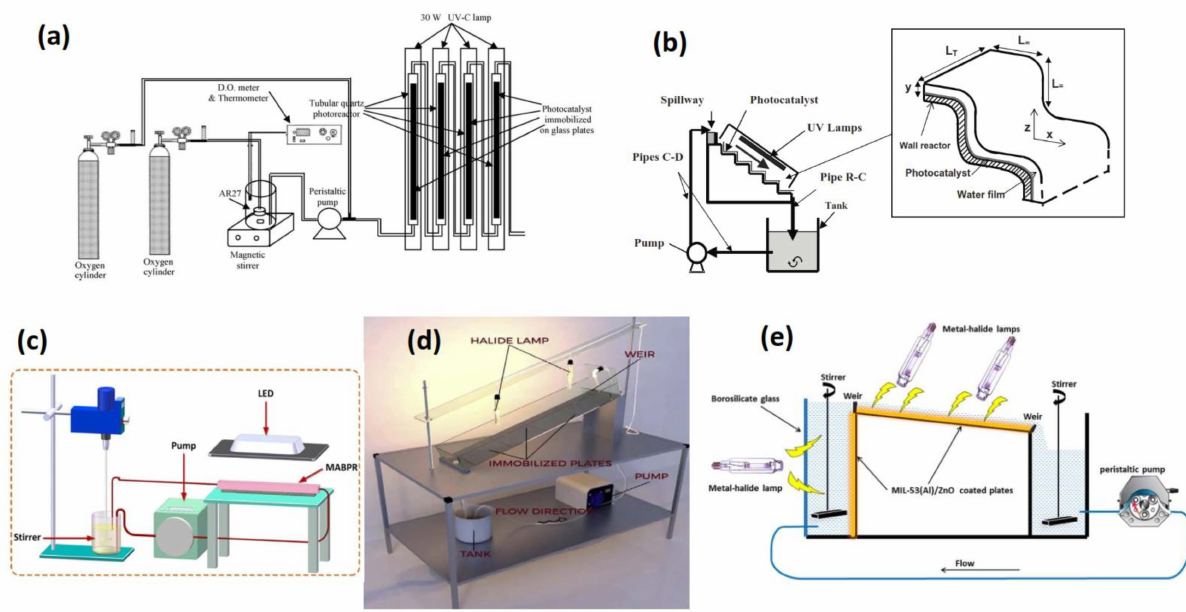
Figure 3. ( a ) Schematic diagram of a tubular continuous reactor with immobilized photocatalyst; ( b ) Thin film cascade photoreactor; ( c ) Magnetic bed reactor; ( d–e ) Examples of thin film fixed-bed reactors; reprinted with permission from [51] ( a ), [58] ( b ), [59] ( c ), [54] ( d ), [56] ( e